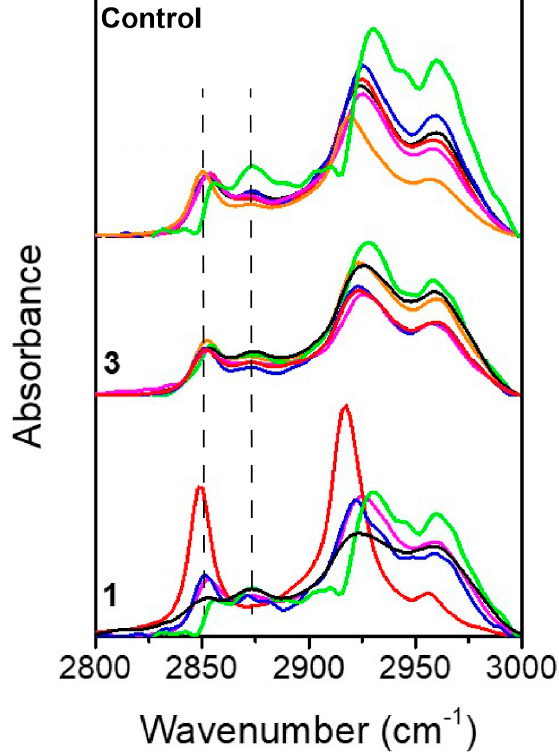
Figure 4. Lipids: FTIR spectra of the lipid region in the region 2800–3000 cm − 1 . In the upper part of the graph, the control samples are shown, then the fraction 3 spectra in the middle and, finally, on the bottom the fraction 1 spectra. Each patient is associated with a specific color: patient 1 is depicted in black, patient 2 in red, patient 3 in blue, patient 4 in pink, patient 5 in orange and patient 6 in green. The two dashed lines are used to indicate the 2853 cm − 1 and the 2870 cm − 1 peaks considered for the analysis.